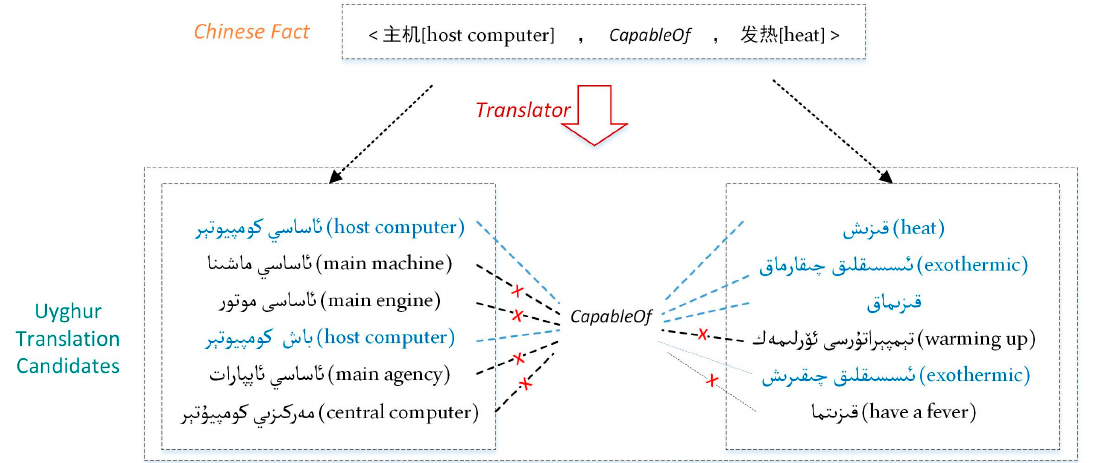
Figure 1. An example of translation ambiguity in Chinese–Uyghur commonsense knowledge base (CKB) translation. Black words represent the semantically unrelated translation candidates while blue words represent the retained candidates after back-translation.